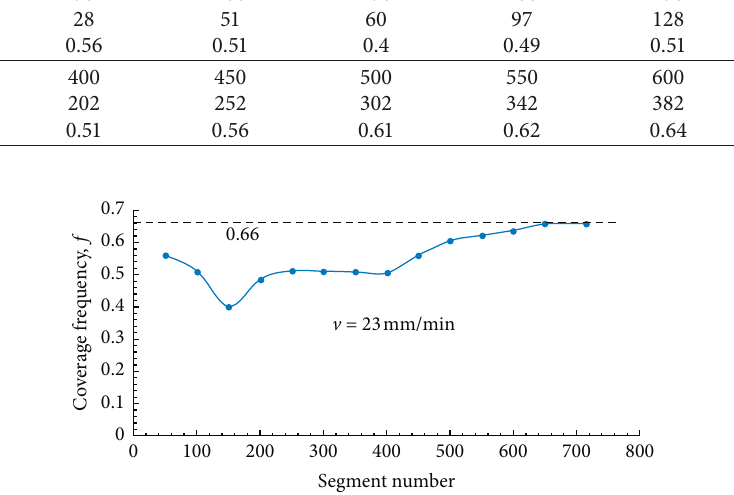
Figure 4: Membership frequency of 23mm/min belonging to the “normal excavation